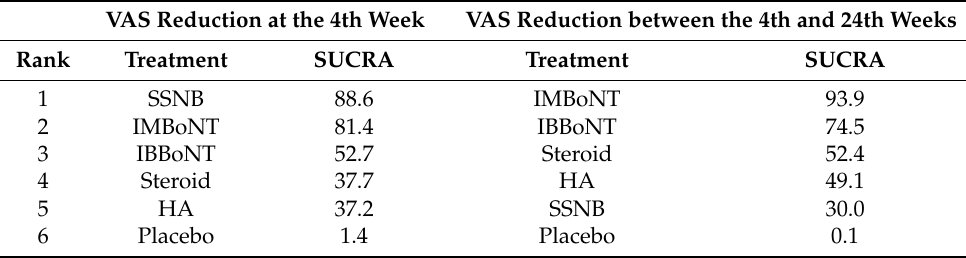
scale (VAS) at the 4th week and between the 4th and 24th